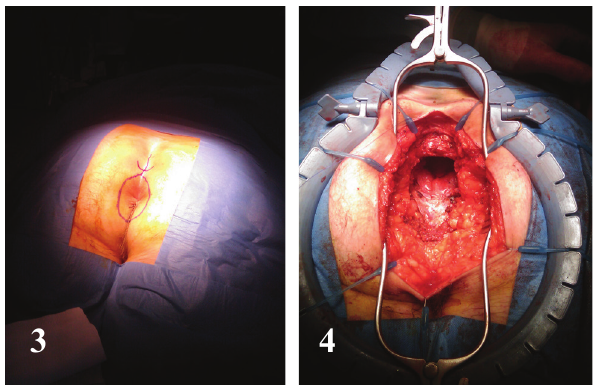
Figure 3. Pre-surgical marking at perineum Figure 4. Perineal surgery in progress, loan star retractor in